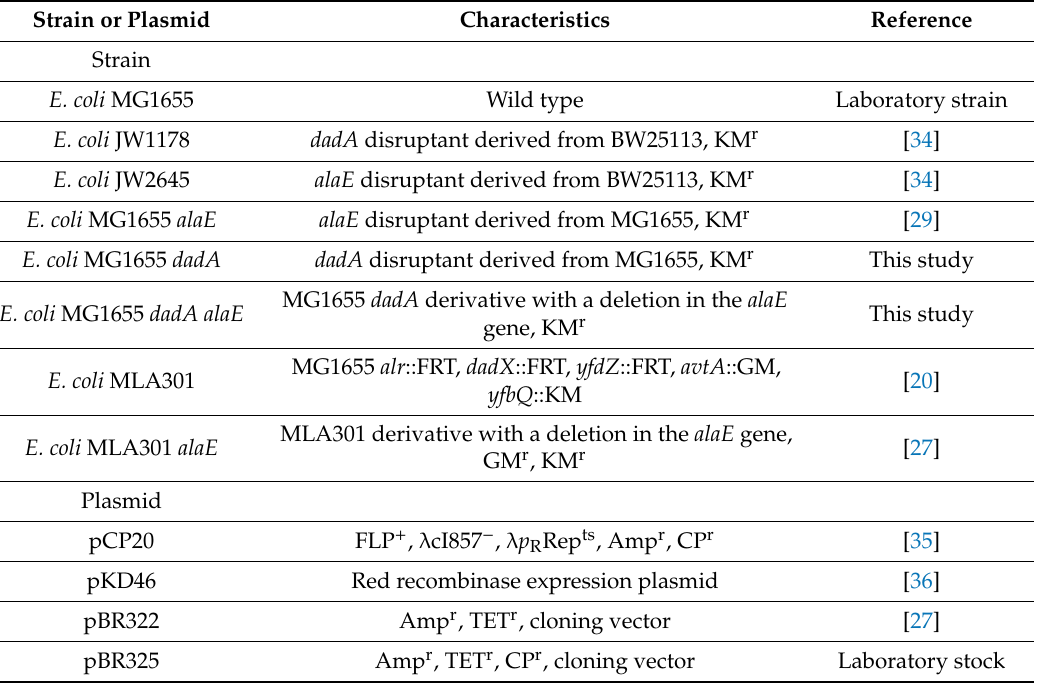
Table 2. Bacterial strains and plasmids